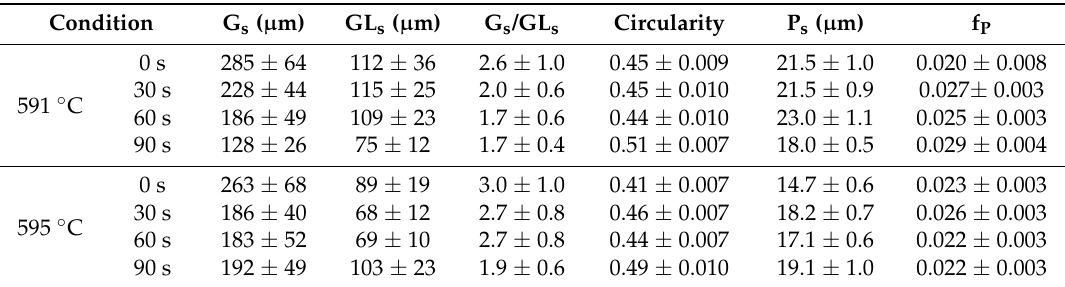
Table 6. Microstructural parameters of B319+Fe alloy after isothermal heat treatment in the semisolid state using different temperatures and soak